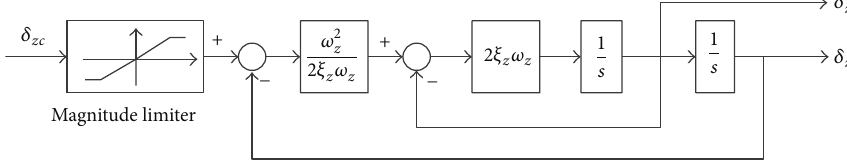
Figure 1: The filter enforcing magnitude